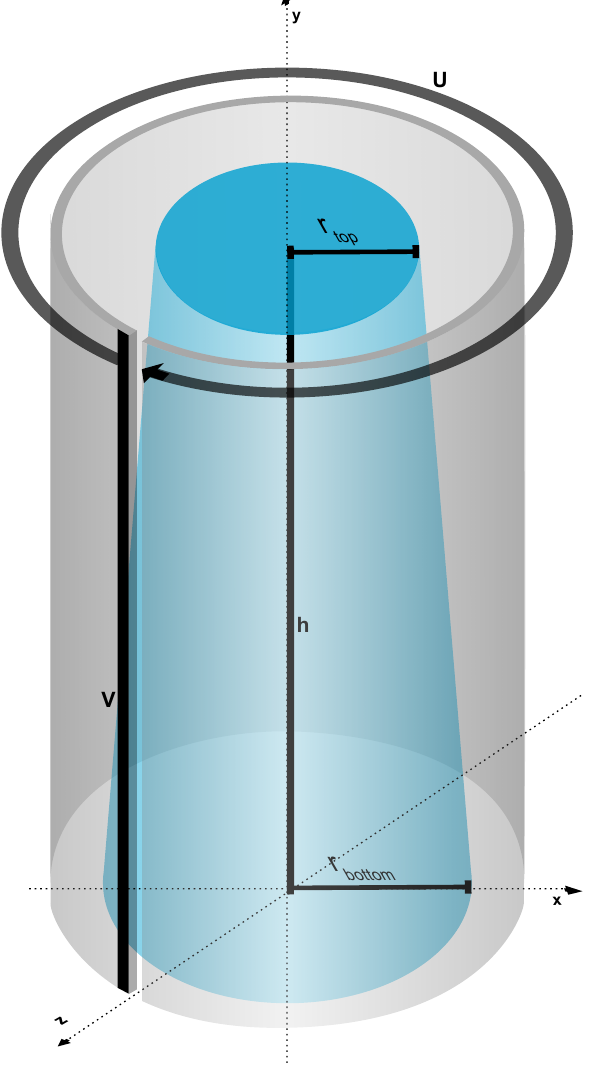
Figure 1. Two example images of the dataset with an approximate tilt of of 56 . 3 ◦ (top left) and 27 ◦ (bottom right).